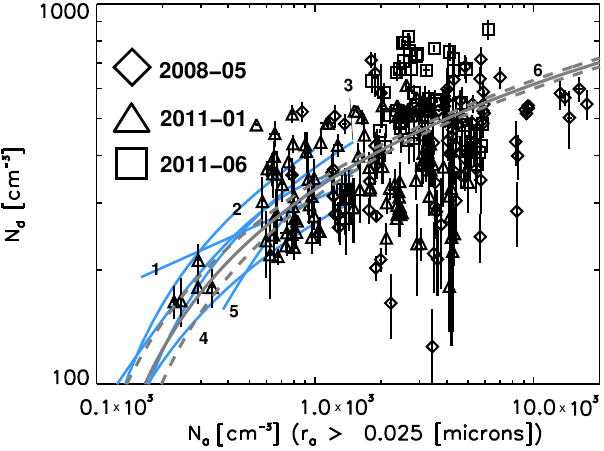
Figure 18. Lidar-derived cloud-base number density ( N d ) and SMPS ground-based number density of aerosols with radii greater than 0.025µm adjusted for density at the cloud-base altitude ( N a ). The symbols follow the same conventions as Fig. B1. The light- blue lines (labelled 1–5) represent previously defined independent empirical relationships based on in situ measurements made with the aid of aircraft. Line-1 corresponds to Eq. (37), 2 corresponds to Eq. (38), 3 corresponds to Eq. (39), 4 corresponds to Eq. (40) and 5 corresponds to Eq. (41) The grey lines (6) show the fit to the points produced using Eq. (42) along with the 1-sigma error